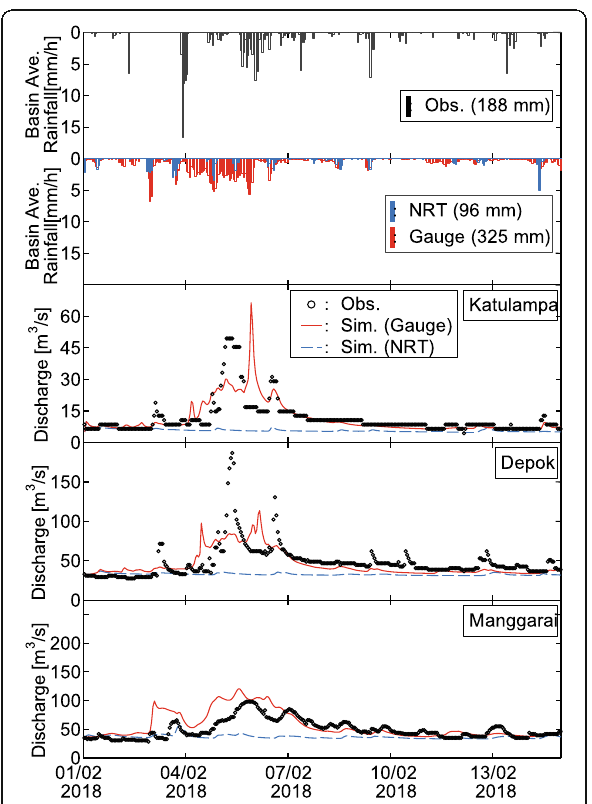
Fig. 8 Hydrograph comparisons for flood event of 2017 Fig. 9 Hydrograph comparisons for flood event of